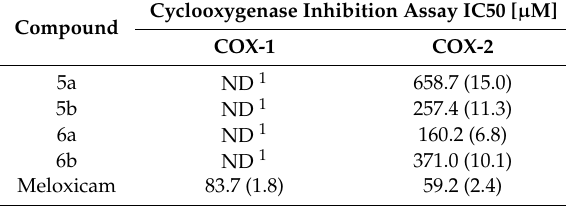
Table 1. IC 50 values determined for COX-1 and COX-2 enzymes; data are presented as mean and SD (standard